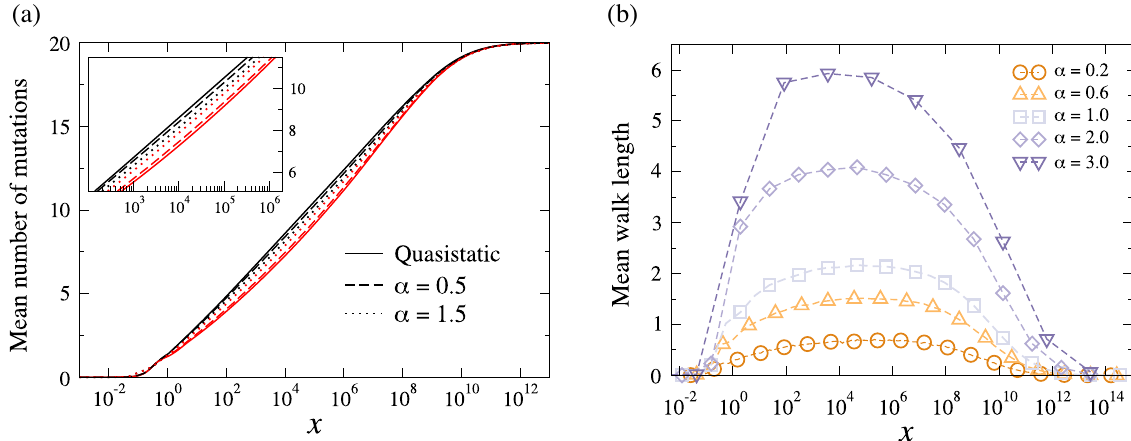
FIG. 7. Average properties of evolutionary trajectories along the main loop under finite driving rates α . (a) Simulation results for the mean number of mutations along the main hysteresis loops have been plotted for different values of the jump sizes in concentration. The concentration has been changed in discrete steps by factor of h m i α . The quasistatic case corresponds to the limit α → 0 . The inset shows an enlarged version for clarity. (b) The length of adaptive walks has been plotted as a function of concentration for various values of α . Adaptive walk lengths exceeding one step imply that secondary mutations have occurred.